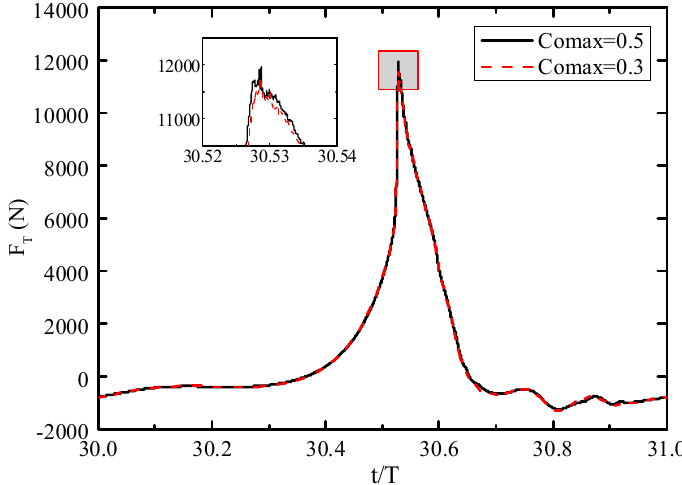
Figure 3. Time-step refinement study for the breaking wave forces on the vertical cylinder.